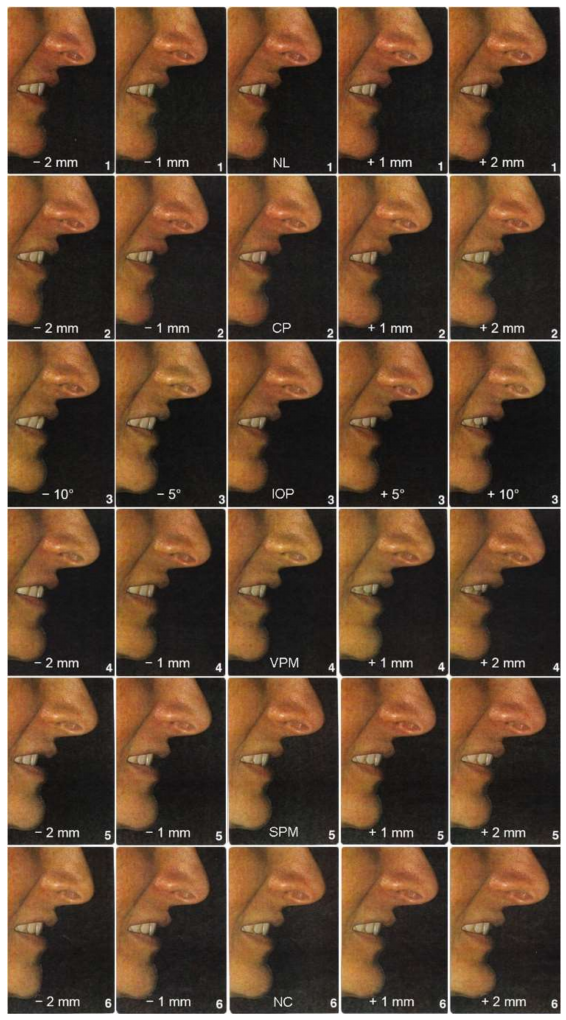
Figure 1. The six series of modified photos. In each series, the unmodified variant is always the middle one. Please note that the photos were not administered to the respondents in this format, but instead were in a photo album, in random order, and without any labeling. This collage was created only as an illustration to ease the interpretation of the results. The numbers in the bottom right corner of the individual images (1 to 6) denote the number of the series. NL: nose length, CP: chin prominence, IOP: occlusal plane inclination, VPM: vertical position of maxillary arch, SPM: sagittal position of the maxillary arch, NC: nose length and chin